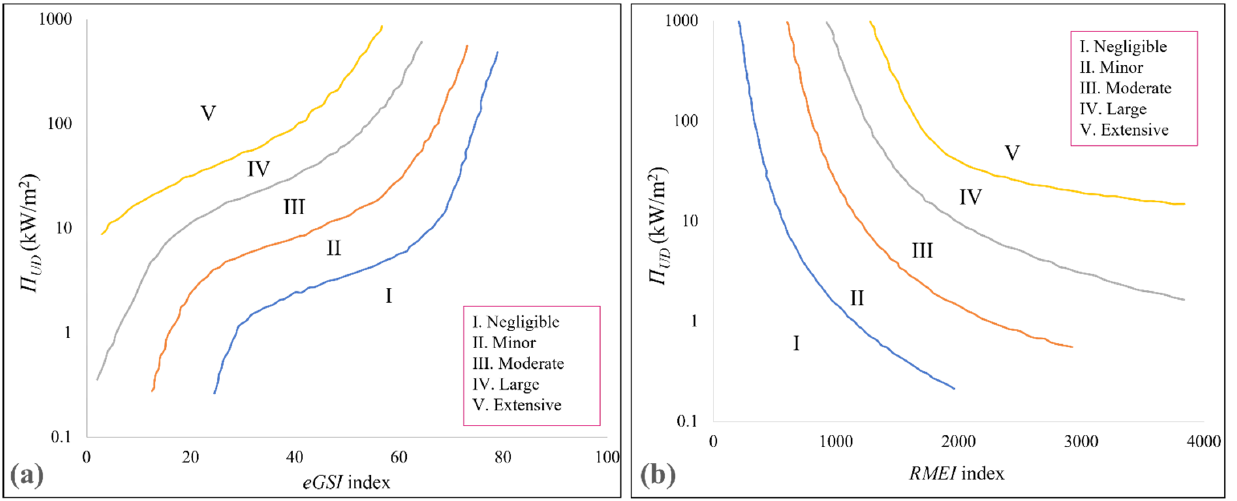
Figure 5. ( a ) Erosion classes determined according to the eGSI index; ( b ) erosion classes determined according to the RMEI index [39].